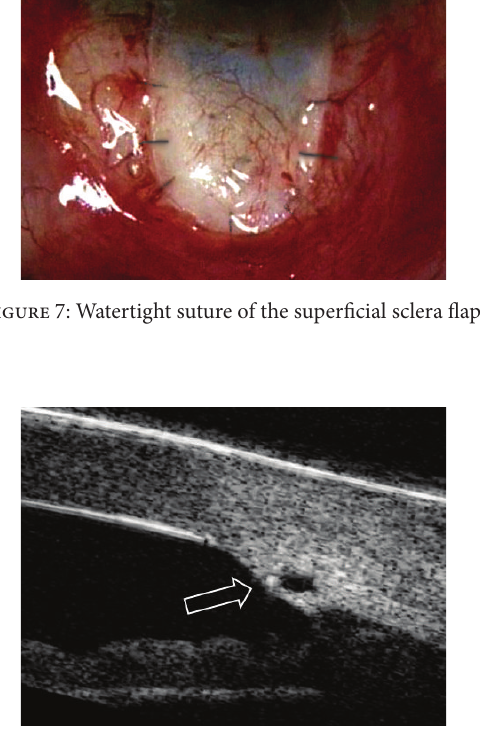
Figure 8: UBM image showing the enlarged Schlemm’s canal and the prolene suture within the canal